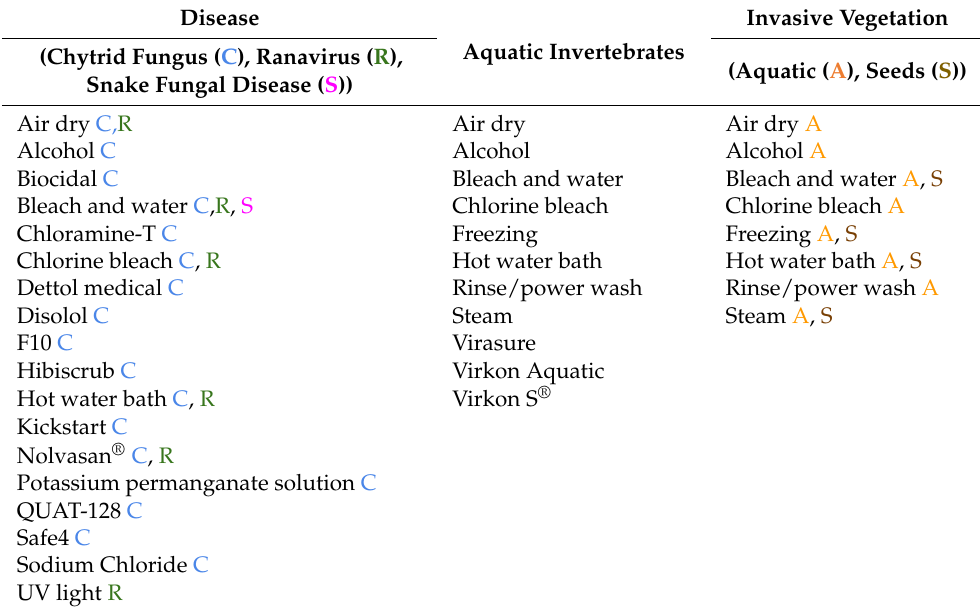
Table 1. Methods used to control the spread of invasive plants, invertebrates, and diseases in wetlands. Concentrations, durations, target organisms, and references are found in Supplementary Materials Table S1. Disease Invasive Vegetation Aquatic Invertebrates (Chytrid Fungus (C), Ranavirus (R), Snake Fungal Disease